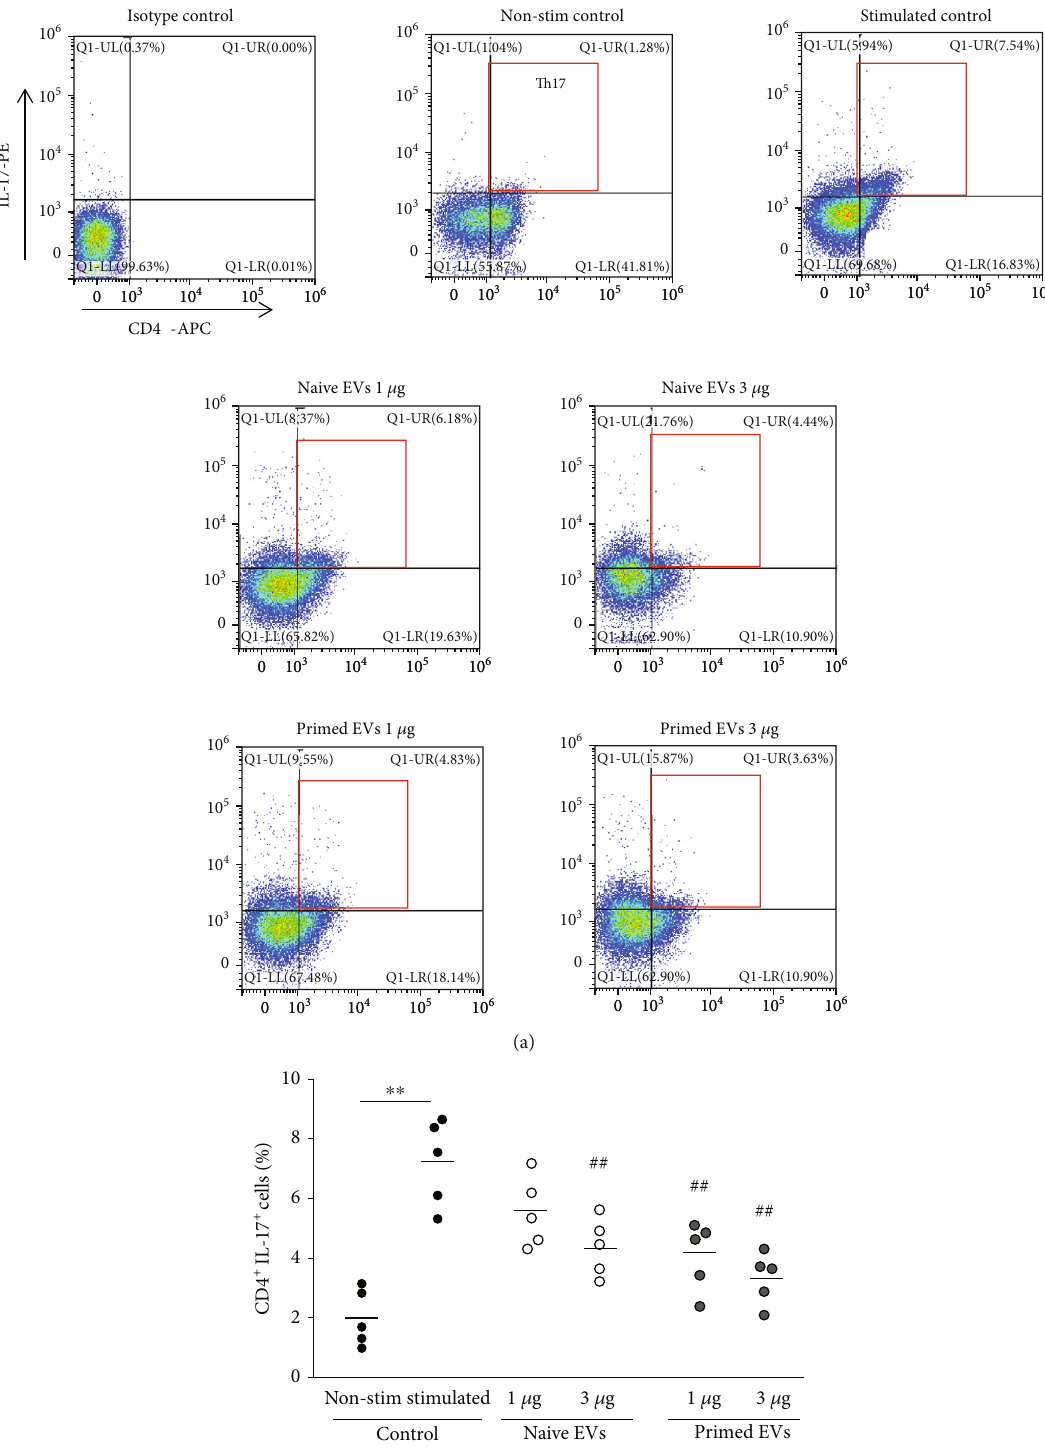
Figure 9: Di ff erentiation into Th17 cells after coculture of PBMCs with cADSC-EVs. (a) Flow cytometric detection of CD4 + IL-17 + cells among CD3 + T cells (gated in red square). Non-stim control: PBMCs that were not stimulated with PMA and ionomycin Stimulated control: PBMCs after coculture with cADSC-EVs and stimulated by PMA and ionomycin. (b) Comparison of CD4 + IL-17 + cells among CD3 + T cells after coculture of PBMCs with various concentrations (1 or 3 μ g/ml) of naive or primed cADSC-EVs. The ratio of Th17 cells was not signi fi cantly di ff erent between naive and primed EVs at the same concentrations. The solid line indicates the average. ## P < 0 : 01 vs. stimulated control. ∗∗ P < 0 : 01 , between